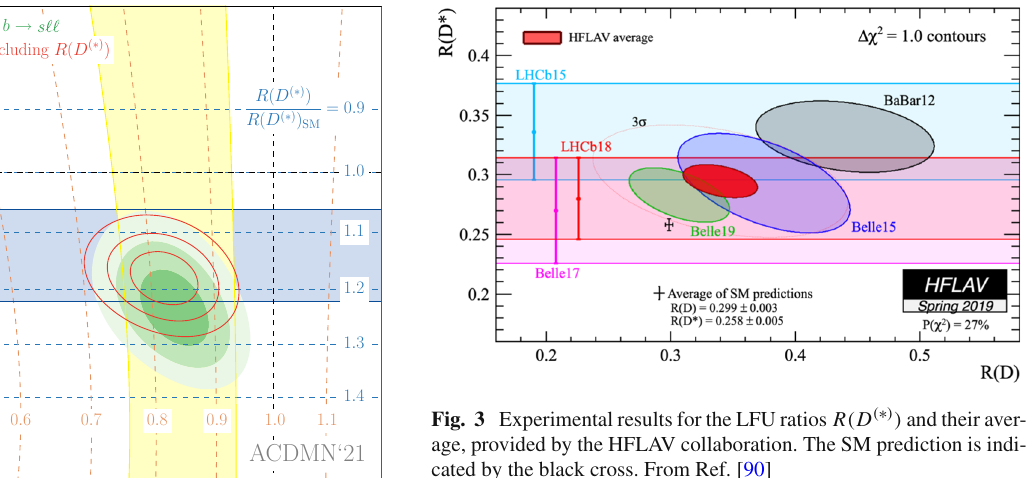
Fig. 2 Preferred regions at the 1, 2 and 3 σ level (green) in the ( C V , C U ) plane from b → s (cid:2) + (cid:2) − data. The red contour lines show − C V 10 μ 9